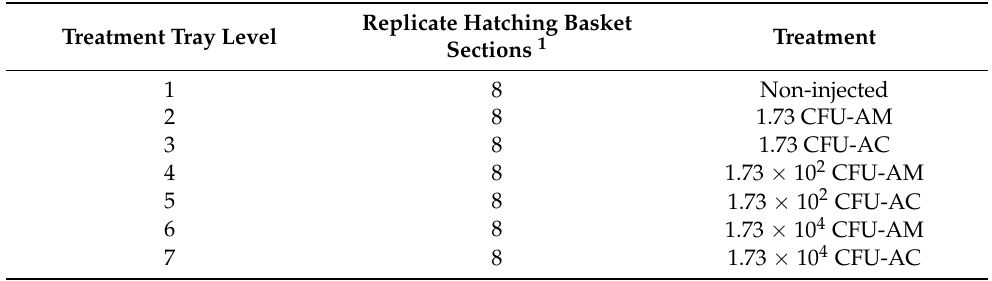
Table 2. Experimental design in the hatchery unit containing eggs belonging to the following treatments: the non-injected control, 1.73, 1.73 × 10 2 , and 1.73 × 10 4 6/85 MG CFU doses injected into the amnion (AM) or air cell